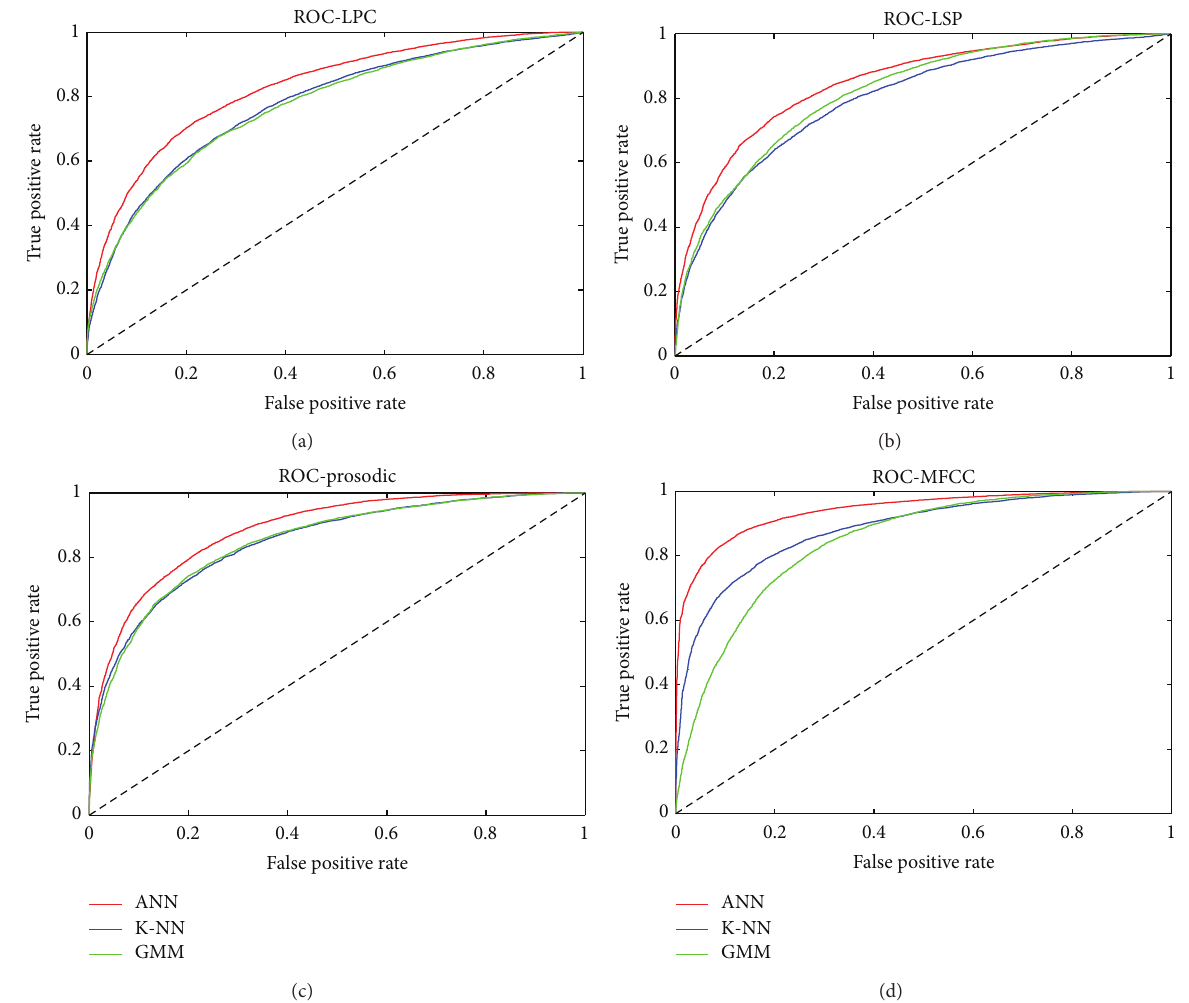
Figure 3: Receiver operating characteristic of GMM, 𝑘 -NN, and ANN classifier in neutral state versus stress recognizing for LPC, LSP, prosodic, and MFCC features.